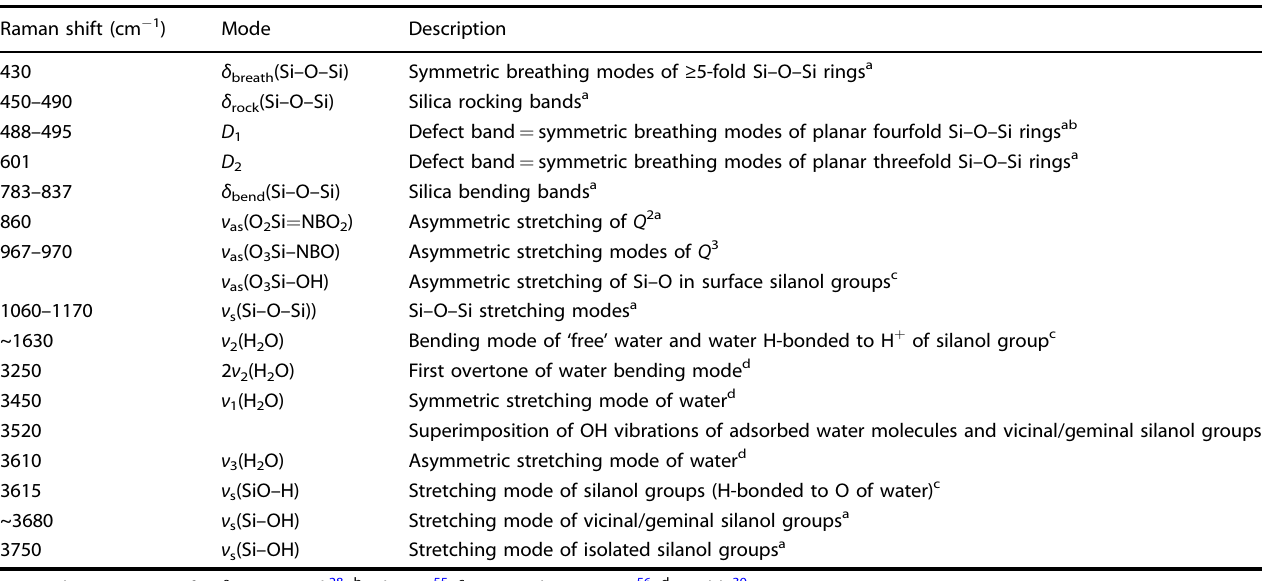
Table 1. Overview of relevant Raman modes found in amorphous silica.